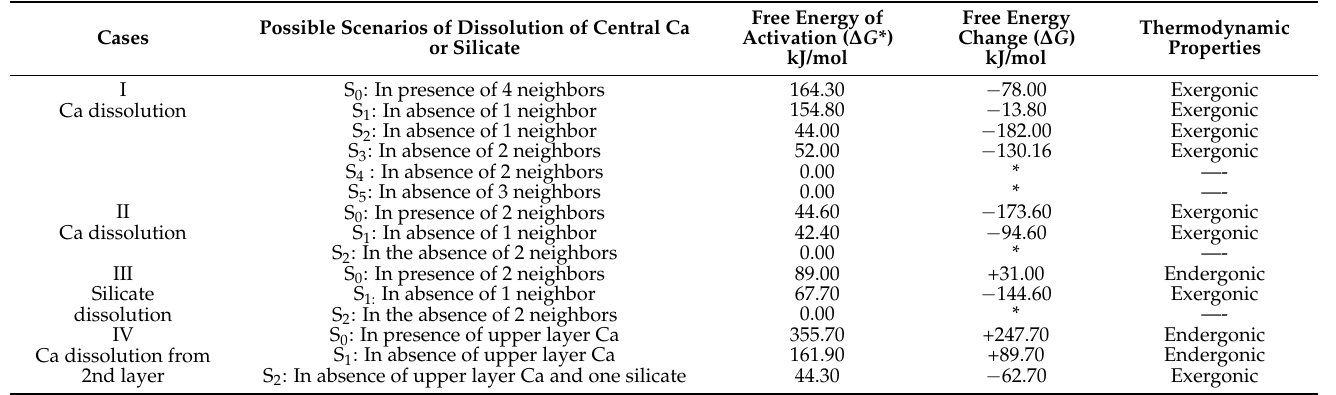
Table 1. Thermodynamic properties of different cases with possible dissolution scenarios of calcium and silicate from the (100) facet of β -C 2 S at 298